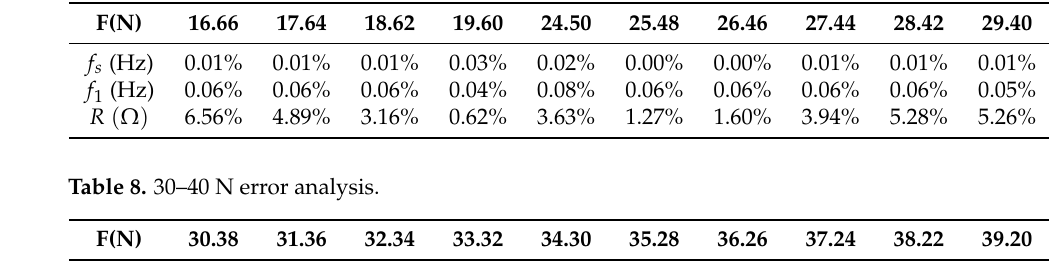
Table 7. 0–30 N error analysis.